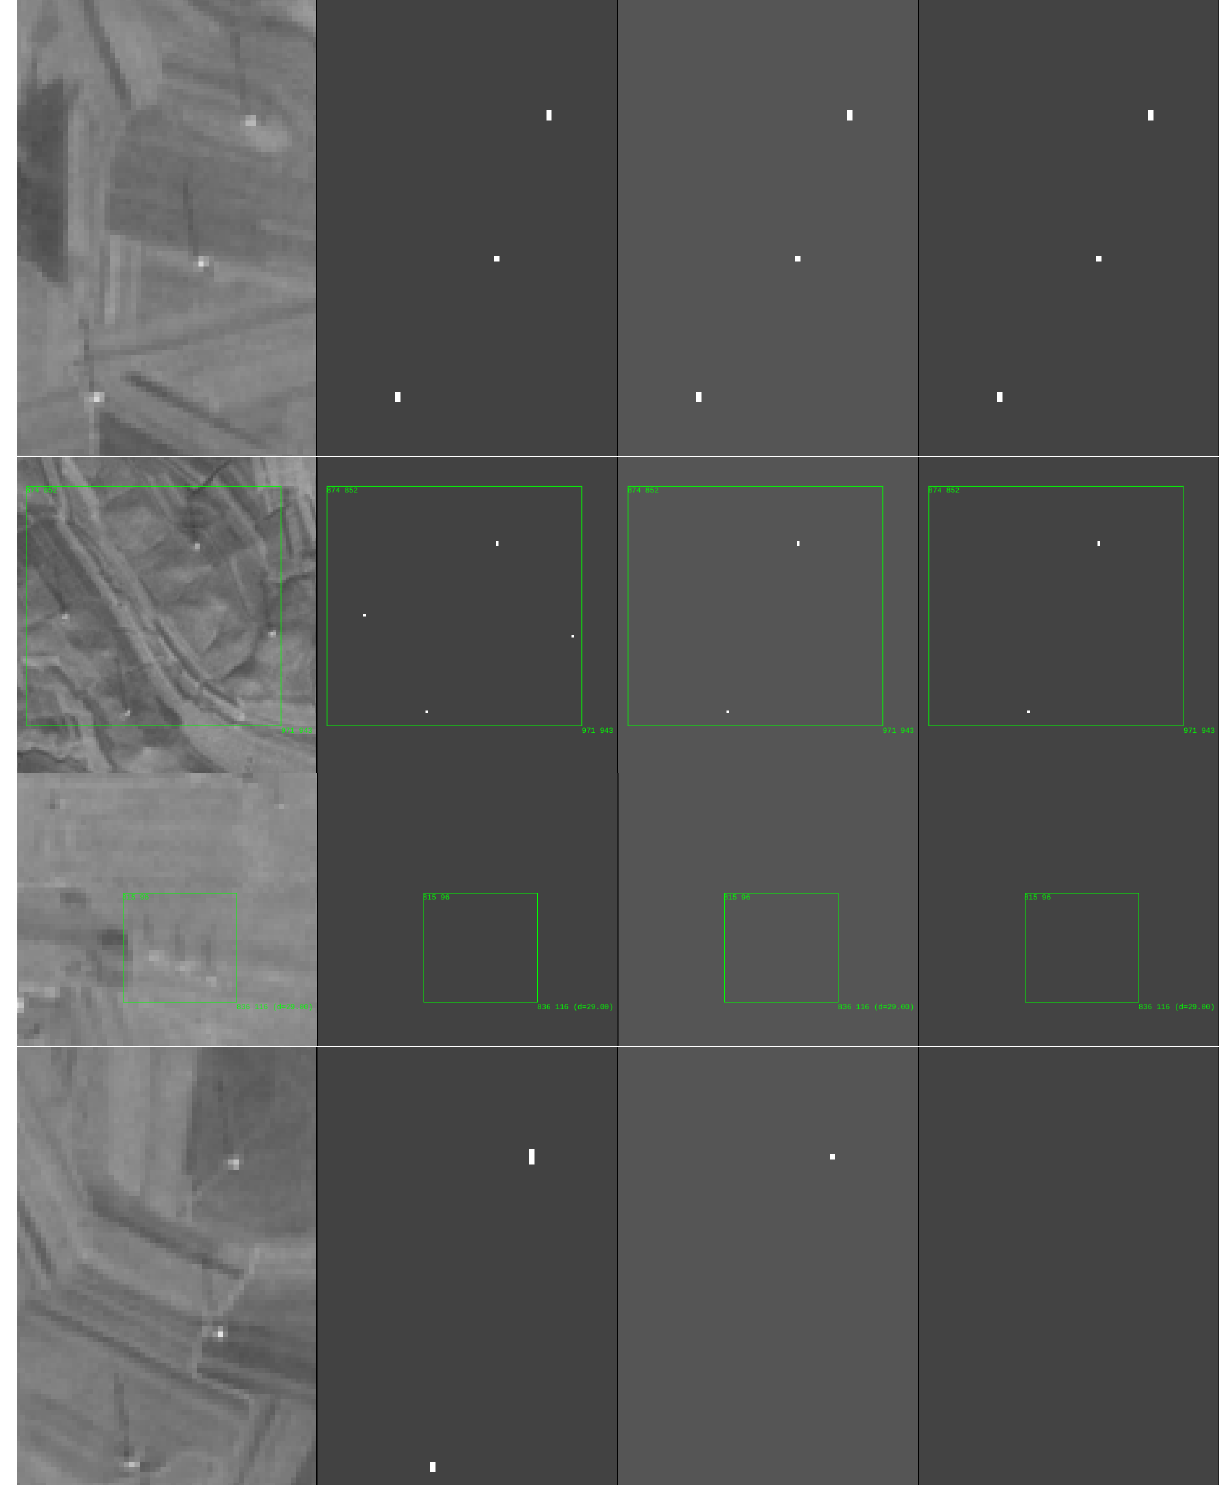
Figure 9. Good results of multidate detection. The first column is the Sentinel-2 scene, the second one is the final detection map with ϵ = 1 , the third one is the detection map with ϵ = 0 . 1 , the final one is the detection map with ϵ = 0 . 01 . Each row shows a different example. On the detection maps, white pixels are detections, black ones are not. On some of the rows, a rectangular green box is drawn to ease the matching between the